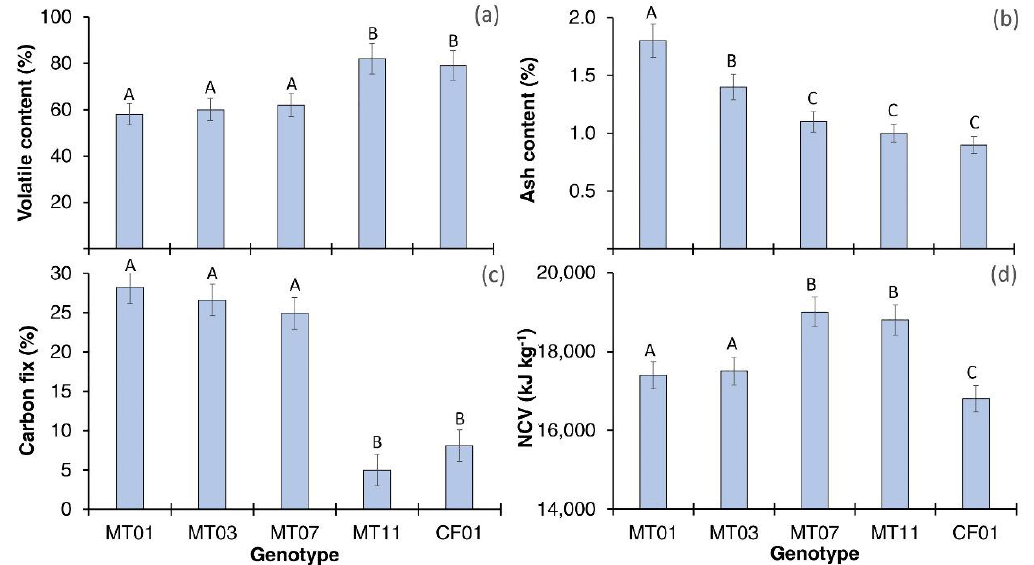
Figure 3. ( a ) volatile content; ( b ) ash content; ( c ) carbon fix; ( d ) NCV for five genotypes of M. textilis . Note: Different letters show significant differences at 0.05.